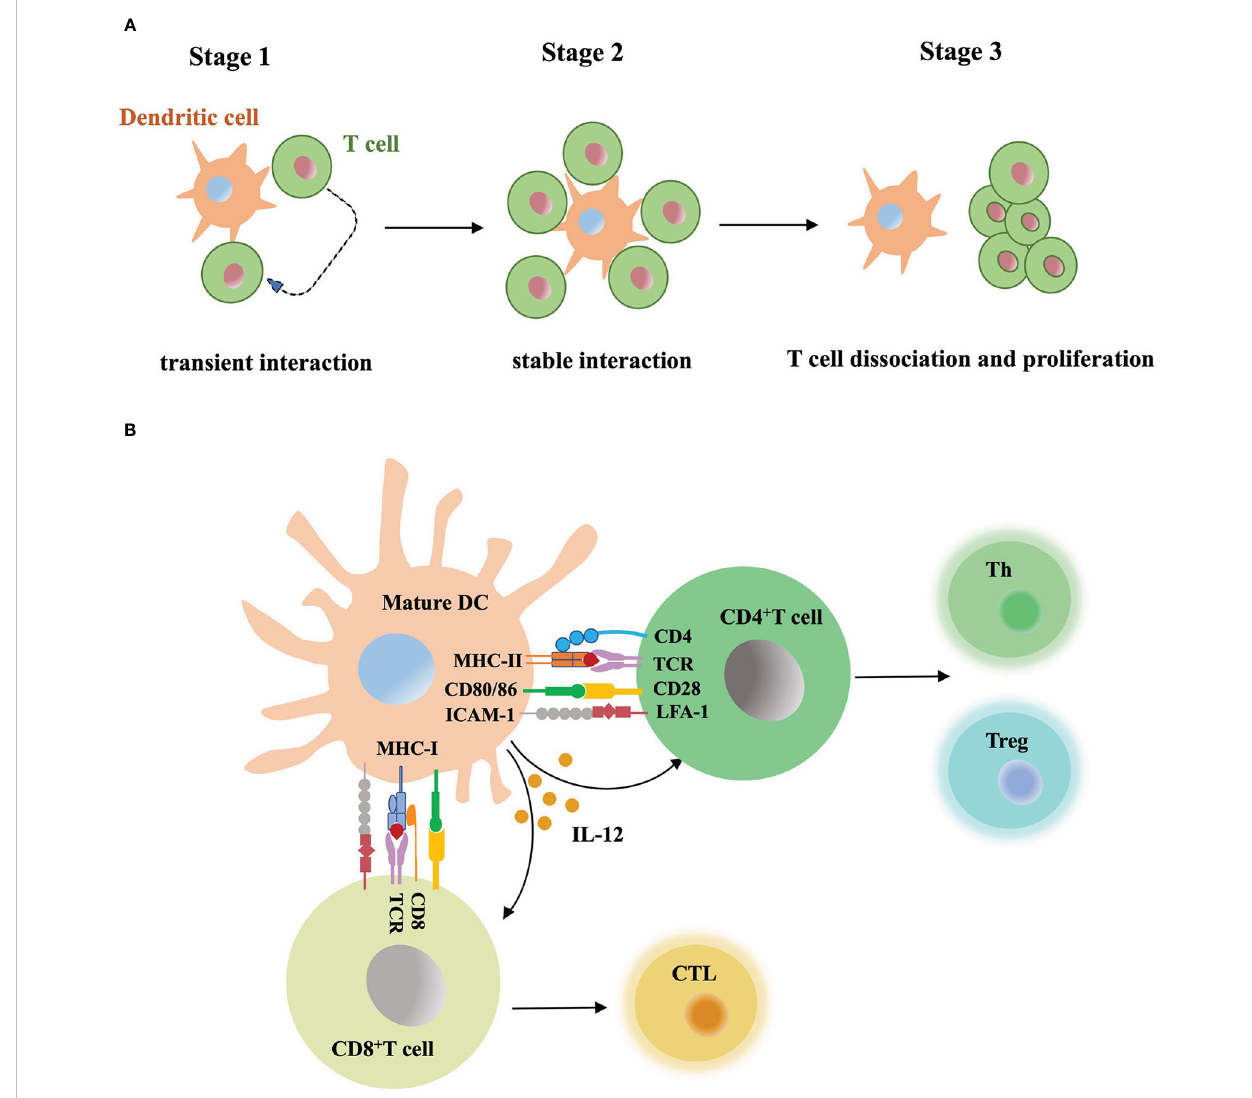
FIGURE 3 DC-T cell interaction (A) Three stages of T-cell priming. (1) Transient interaction; (2) Stable interaction; (3) T-cell dissociation and proliferation. (B) T cell activation through DC contact. Mature DCs prime naïve T cells by presenting MHC-bound antigens, providing costimulatory signals (CD80, CD86 etc) and secreting mediators such as IL-12, DCs instruct differentiation of CD8 + T cells into cytotoxic T lymphocyte (CTL), while instruct CD4 + T cell to differentiate into T helper cell (Th) and regulatory T cell